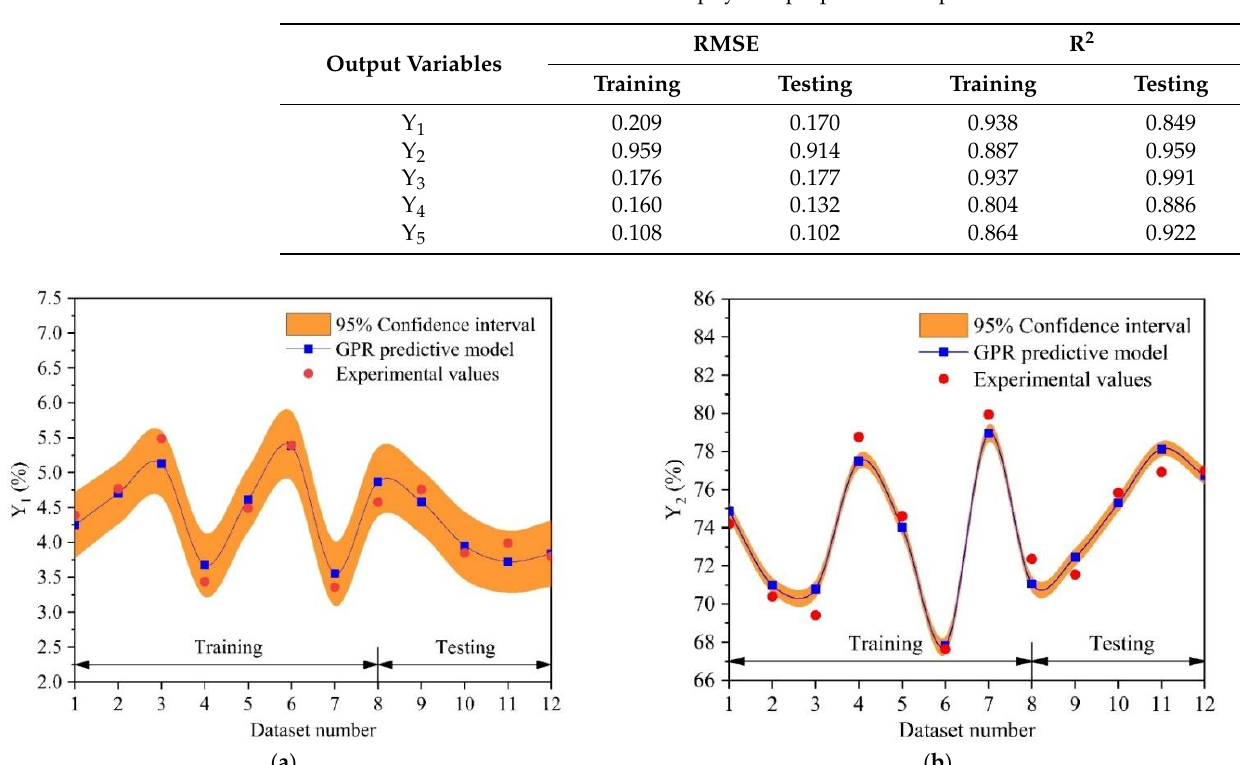
( d ) ( e ) Figure 9. Comparison of the predictive values by GPR versus the experimental values: ( a ) Y 1 ; ( b ) Y 2 ; ( c ) Y 3 ; ( d ) Y 4 ; and ( e ) Y 5 . (2) Proportion Optimization Results for Modified Asphalt Mixture Based on GPR-AWMOPSO According to the above AWMOPSO algorithm, the optimal solution can be obtained for the proportion of asphalt mixture containing diatomite and basalt fibre. The tri-objective modified asphalt mixture optimization results are shown in Figure 10a. GPR